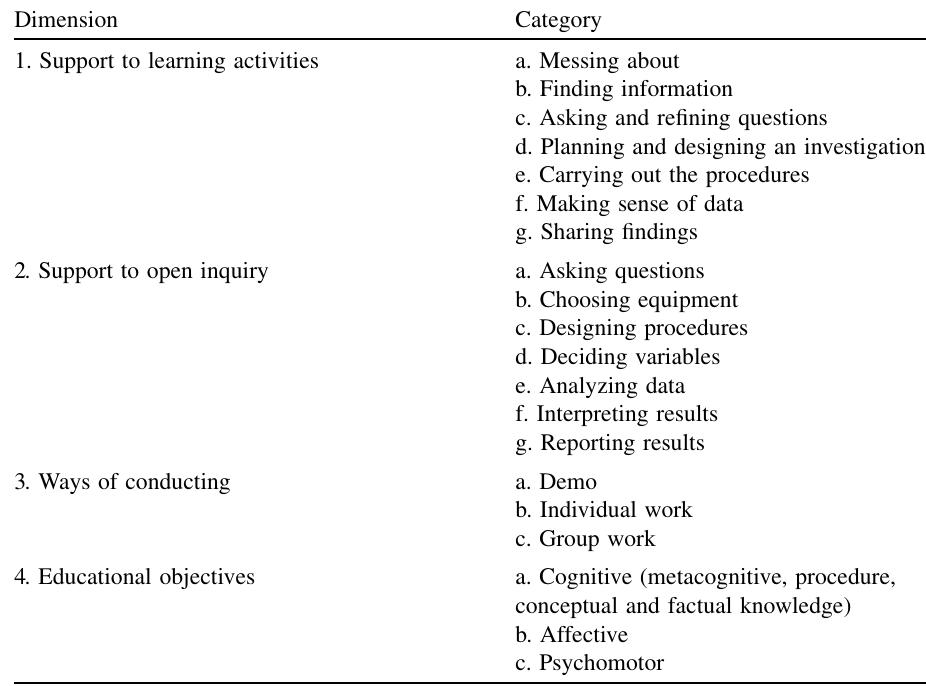
TABLE I. Framework for technology-enhanced laboratories.